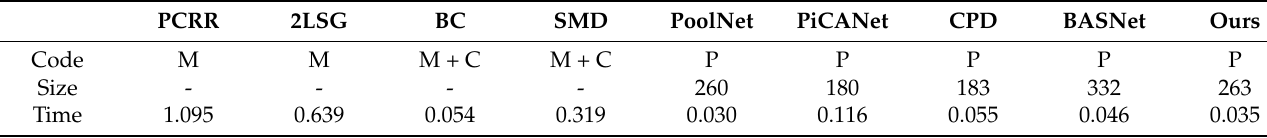
Table 4. Comparison of the model size and the average running